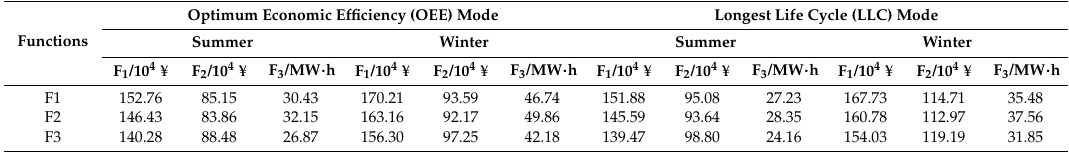
Table 3. The payoff table of the MECS operation in Case